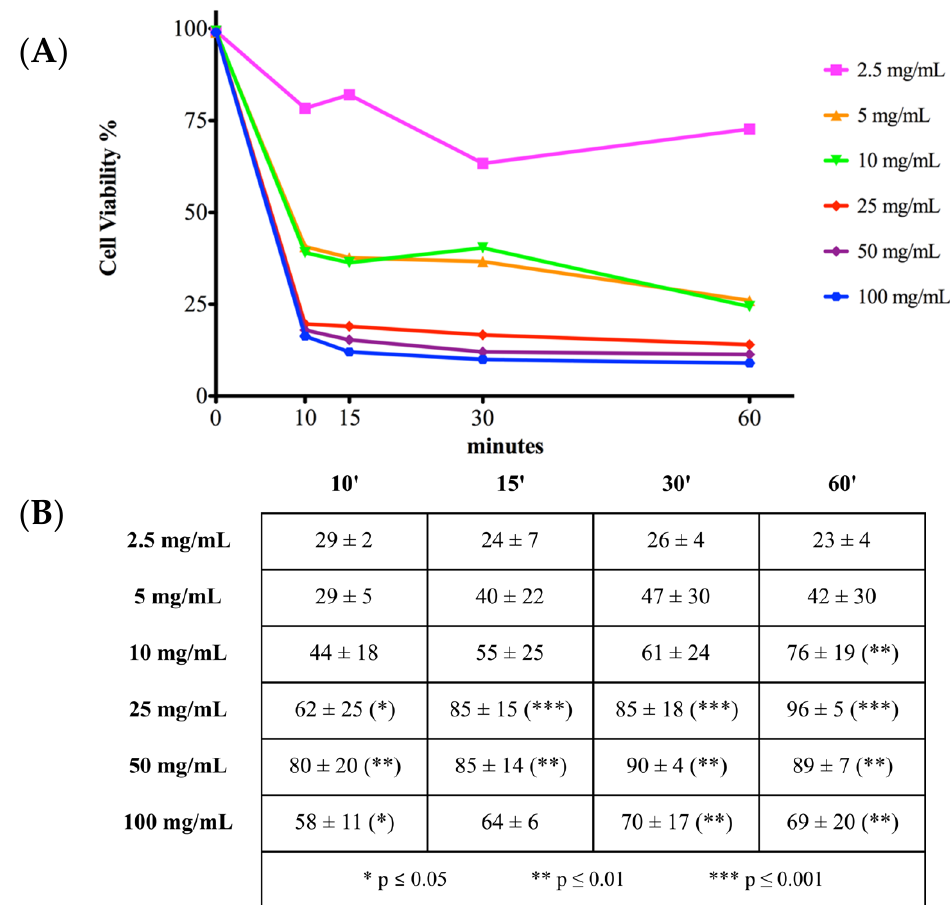
Figure 2. Cell viability dose–time curves. ( A ) Each point corresponds to a vancomycin treatment at a different concentration at a certain time point. Relative cell viability was calculated considering 0 mg/mL vancomycin as a baseline of 100%. ( B ) Cell viability results were expressed as mean reduc- tion of cell viability ± standard deviation for at least three independent experiments. Cell viability was significantly reduced by 10 mg/mL vancomycin at 60 min as well as by 25 mg/mL, 50 mg/mL, and 100 mg/mL approximately at all timepoints. Statistical significance was calculated versus the control group (0 mg/mL vancomycin) and reported as * p ≤ 0.05, ** p ≤ 0.01 and *** p ≤ 0.001. See text for details.